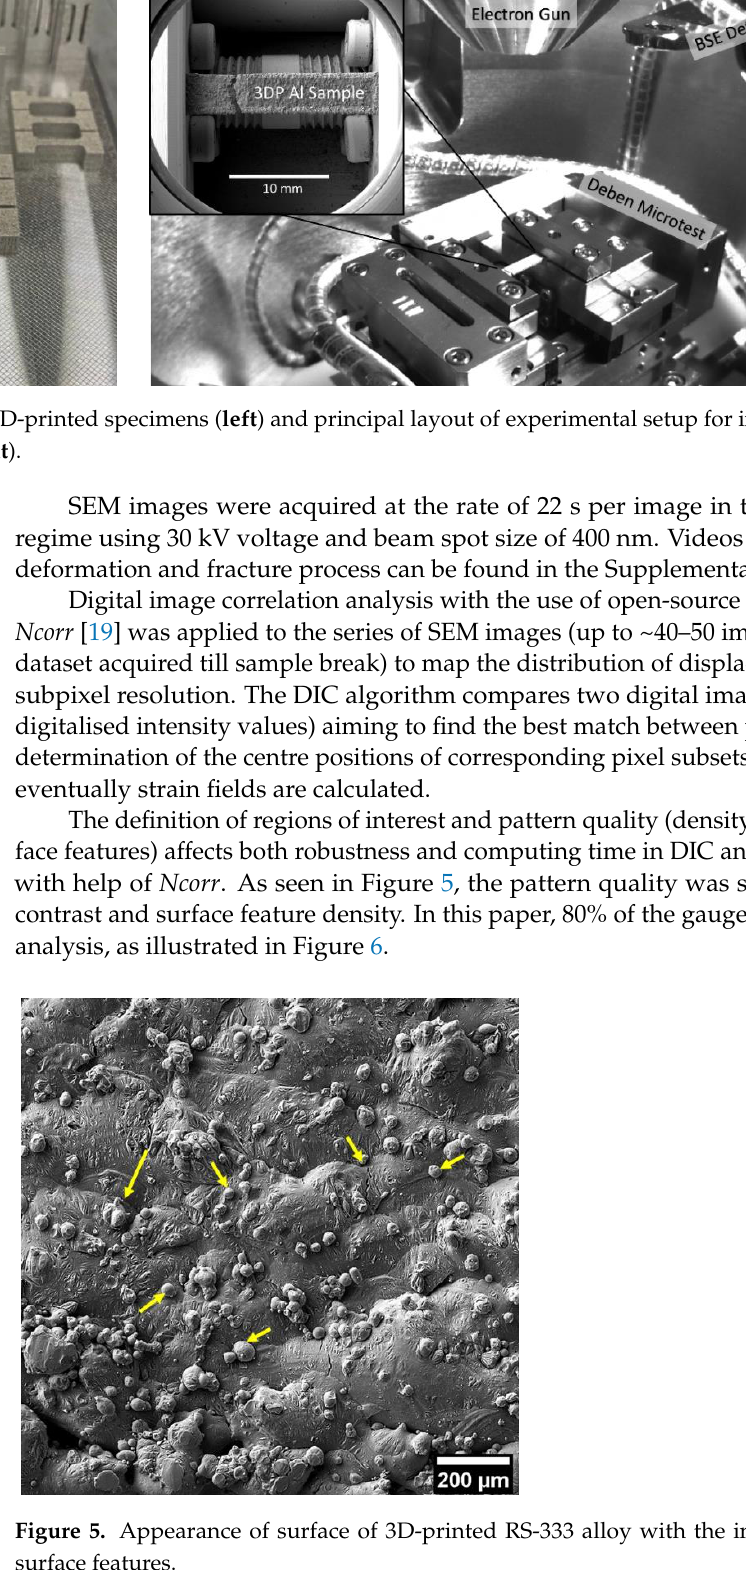
Figure 6. Illustration of typical ROI (Region Of Interest) selection for captured SEM image. An important issue of elongation calibration at loading curves needs to be addressed when elastic moduli and true strains are sought to be derived from raw data acquired from a testing stage such as the Deben Microtest 1kN. Crosshead displacement data are returned from a Linear Variable Differential Transformer (LVDT) sensor. Despite the high accuracy of the LVDT sensor, several factors must be taken into account when loading curves are analysed, namely (1) the effect of machine load frame compliance on the ap- parent deformation, and (2) the non-uniformity of the plastic and total strain (rate) during tensile deformation [20]. In the absence of suitable correction, the apparent deformation